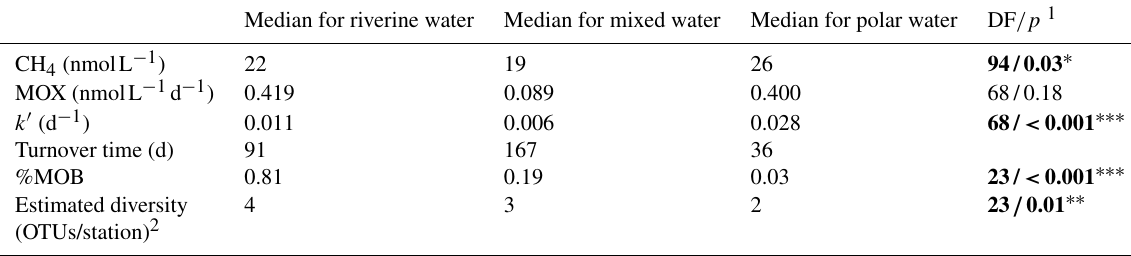
Table 1. The median values of important parameters (methane concentration and oxidation rate, fractional turnover rate k (cid:48) , turnover time, relative abundance and diversity of methanotrophs) in the different water masses. A one-way analysis of variance (ANOVA) was performed on the log-transformed data to test for significant differences between the water masses.